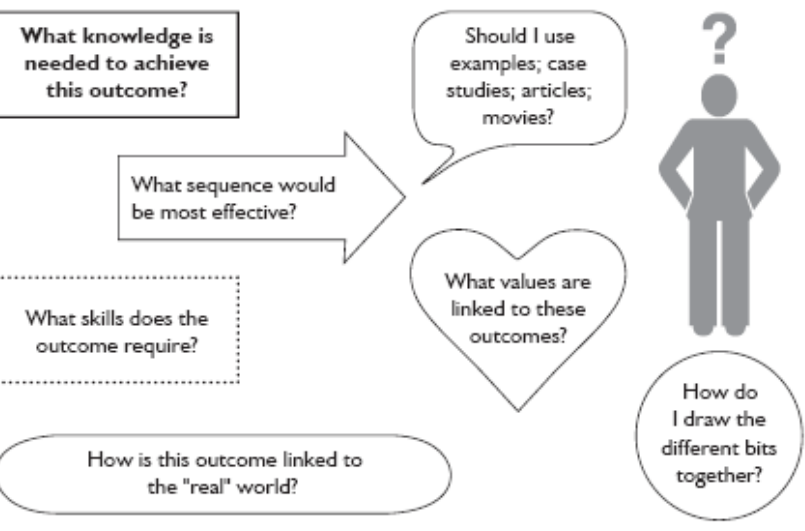
Figure 2 . Designing a learning programme (Source: SAQA, 2005,